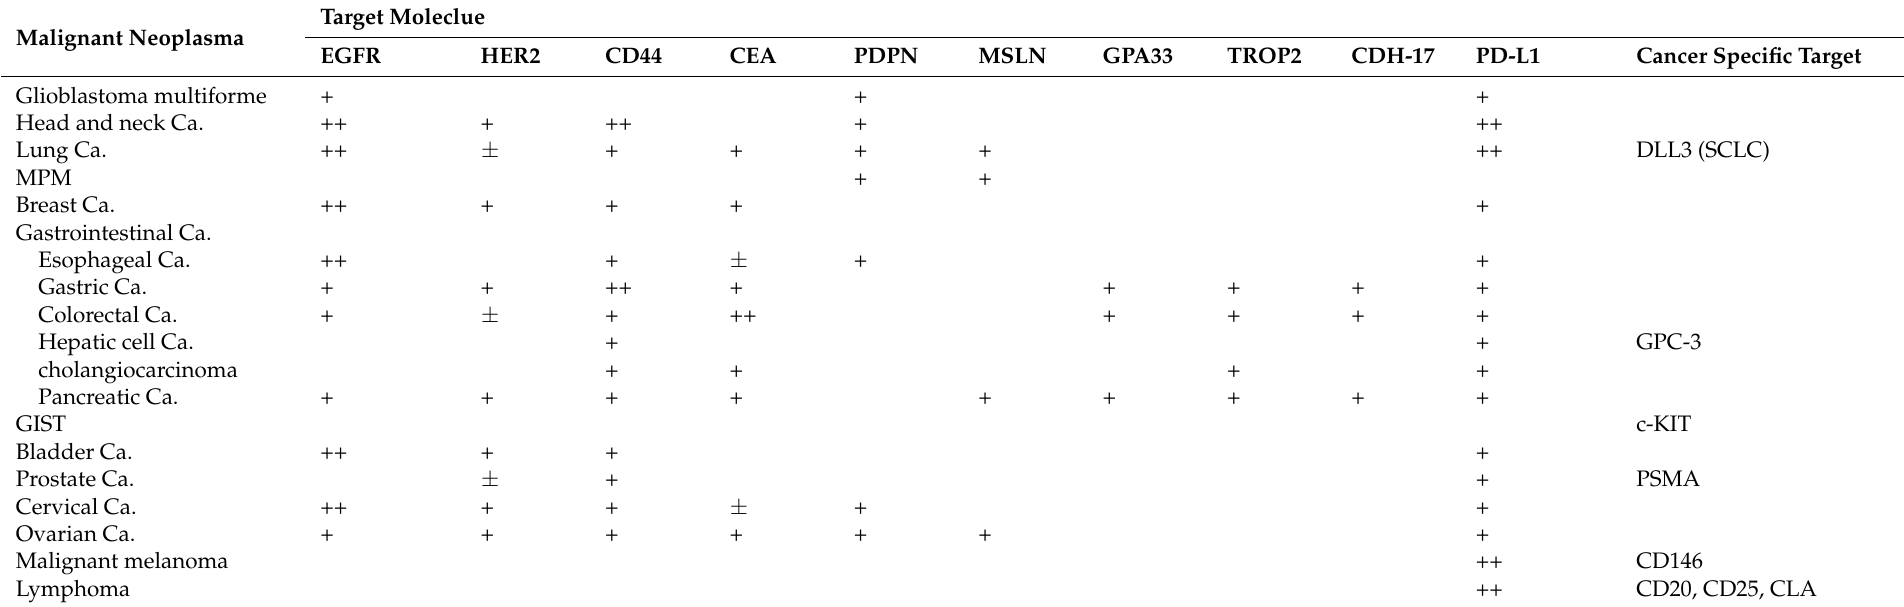
Table 1. Correspondence of molecular targets for each tumor in NIR-PIT targeting cancer